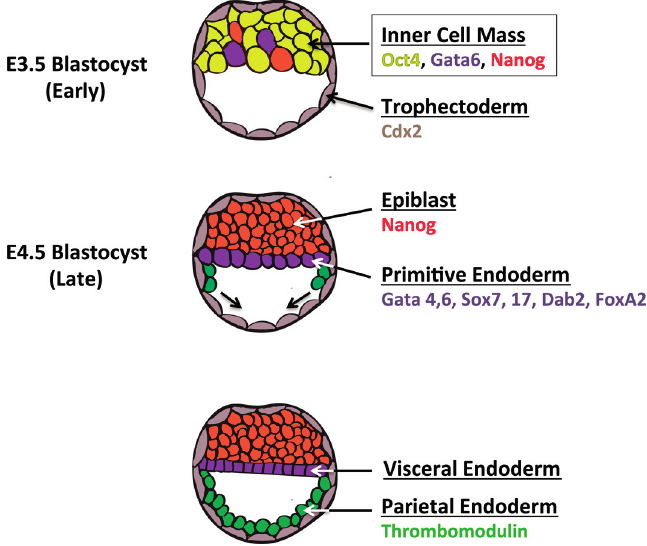
Figure 3. Formation of extraembryonic endoderm in mouse development. Cells of the inner cell mass (yellow), expressing Oct4 , Gata6 and Nanog , and those of the trophectoderm (grey), expressing Cdx2 , are the primary cell populations present prior to implantation of the blastocyst. A second round of segregation leads to cells of the epiblast (red), which continue to express Nanog and will eventually give rise to the three germ layers of the embryo proper, and those committed towards the extraembryonic endoderm lineage that express Gata4 and 6 , Sox7 and 17 , Dab2 and FoxA2 . Soon after, cells of the primitive extraembryonic endoderm that undergo an epithelial-to-mesenchymal transition, migrate on a basement membrane along the trophectoderm and develop as parietal extraembryonic endoderm (green). Primitive endoderm cells still associated with the basement membrane of the epiblast acquire a cuboidal morphology, and develop into visceral extraembryonic endoderm (purple); some of which contributes to definitive